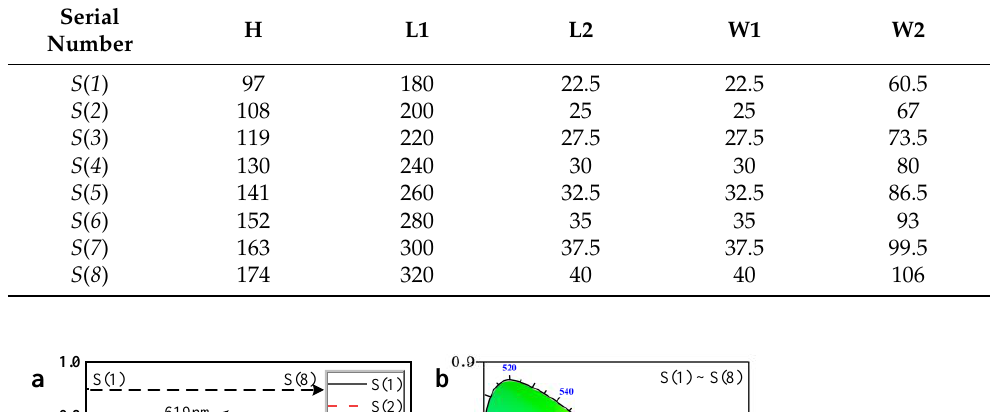
Table 1. Nanoresonator size.